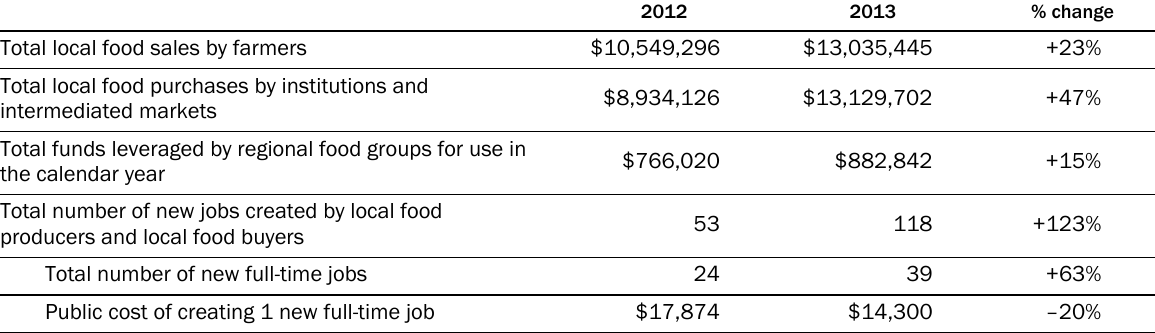
Table 1. Selected Data from Evaluation of the Iowa Regional Food Systems Working Group (all in